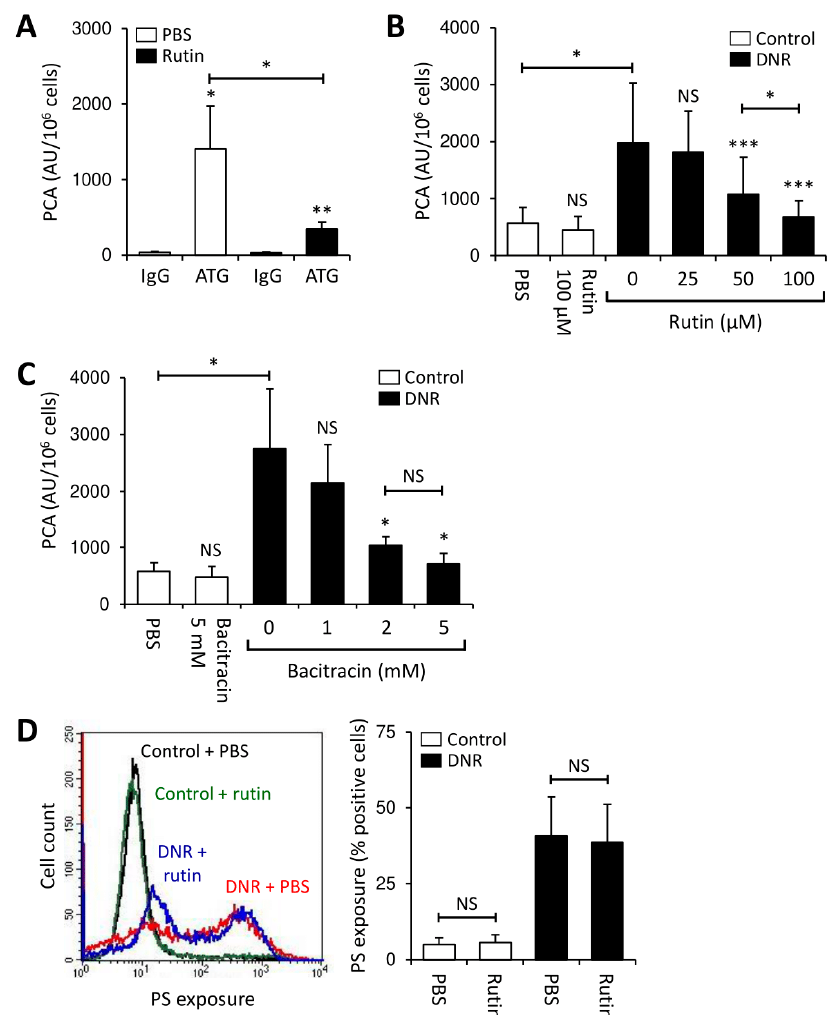
Figure 4. Rutin and bacitracin prevent activation of cryptic TF on THP1 cells. ( A ) THP1 cells were incubated with PBS or rutin (100 µ M) for 24 h at 37 ◦ C, washed and subsequently loaded with 100 µ g/mL ATG or rabbit IgG for 15 min at room temperature. Cells were washed and mixed 1:1 (vol:vol) with normal human plasma (NHP). Following incubation for 5 min at 37 ◦ C, cellular PCA was analyzed by single-stage clotting assay (mean ± SD, n = 6). ( B , C ) Following incubation of THP1 cells with 1 µ M daunorubicin (DNR) for 24 h at 37 ◦ C in the presence of increasing concentrations of rutin (0–100 µ M) (mean ± SD, n = 15) ( B ) or bacitracin (0–5 mM) (mean ± SD, n = 6) ( C ), cells were analyzed for PCA by single-stage clotting assay. ( D ) PS exposure on THP1 cells treated with PBS (control) or 1 µ M DNR in the presence or absence of 100 µ M rutin was measured by flow cytometry. A representative histogram and summary statistics are shown (mean ± SD, n = 3). p -values are according to Tukey’s post-hoc test (NS, not significant; *, p < 0.05; **, p < 0.01; ***, p <